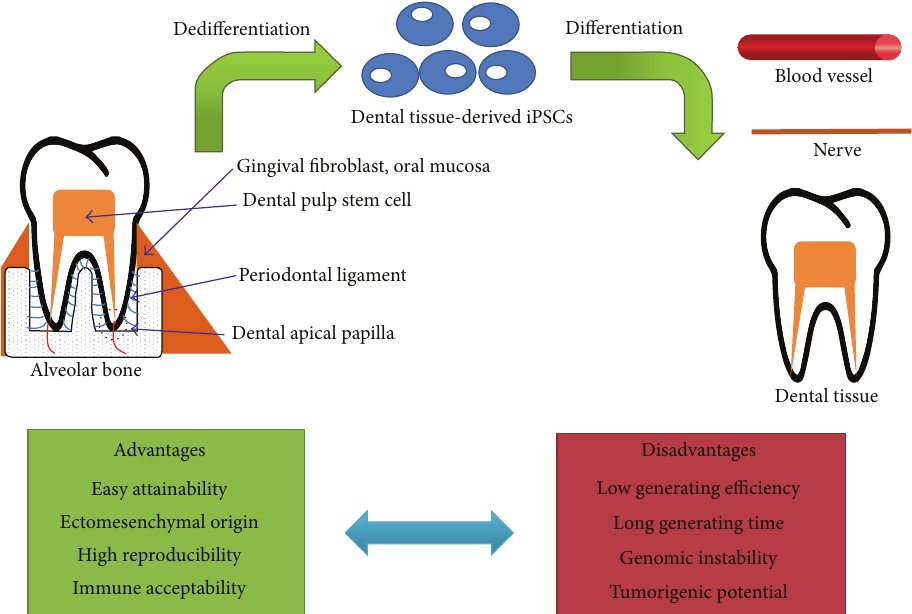
Figure 1: Schematic image showing sources of iPSCs in dental tissue, their regenerative application, advantages and disadvantages.